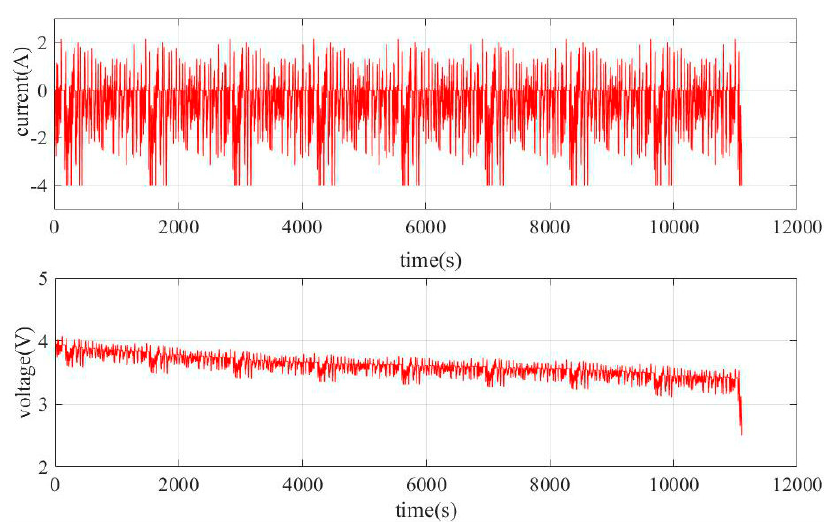
Figure 7. Current and voltage of federal urban driving schedule. Energies 2019 , 12 , x FOR PEER REVIEW